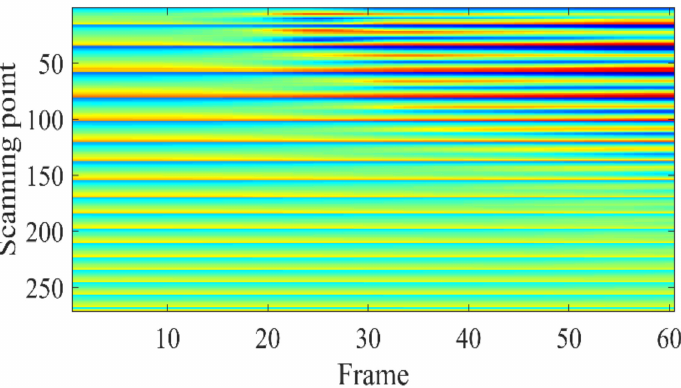
Figure 8. The recovered fully sampled LoS data from down-sampled LoS data.